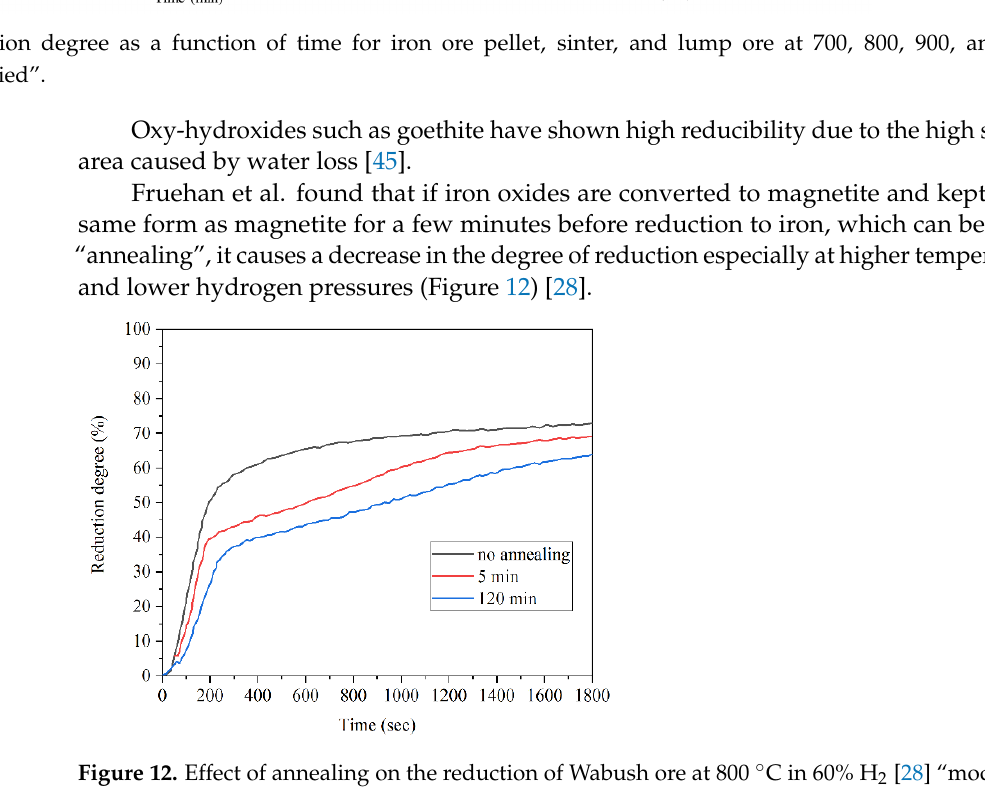
Figure 12. Effect of annealing on the reduction of Wabush ore at 800 °C in 60% H 2 [28] “modified”.